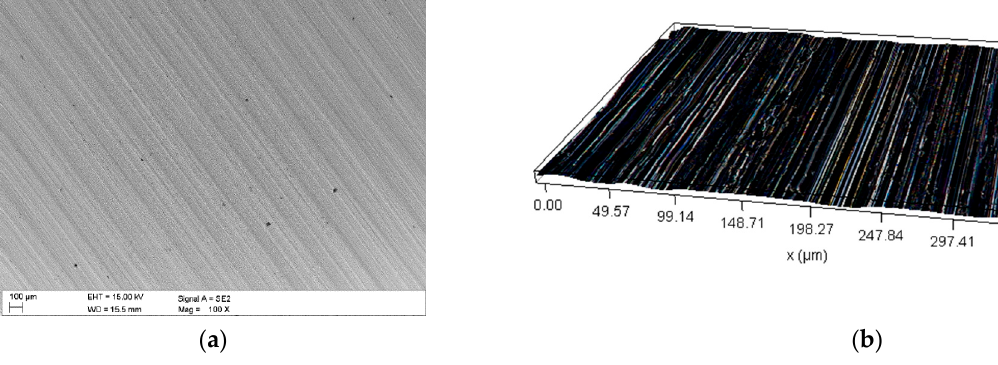
Figure 1. RAEX400 steel, ( a ) Surface view (SEM), ( b ) Surface profile